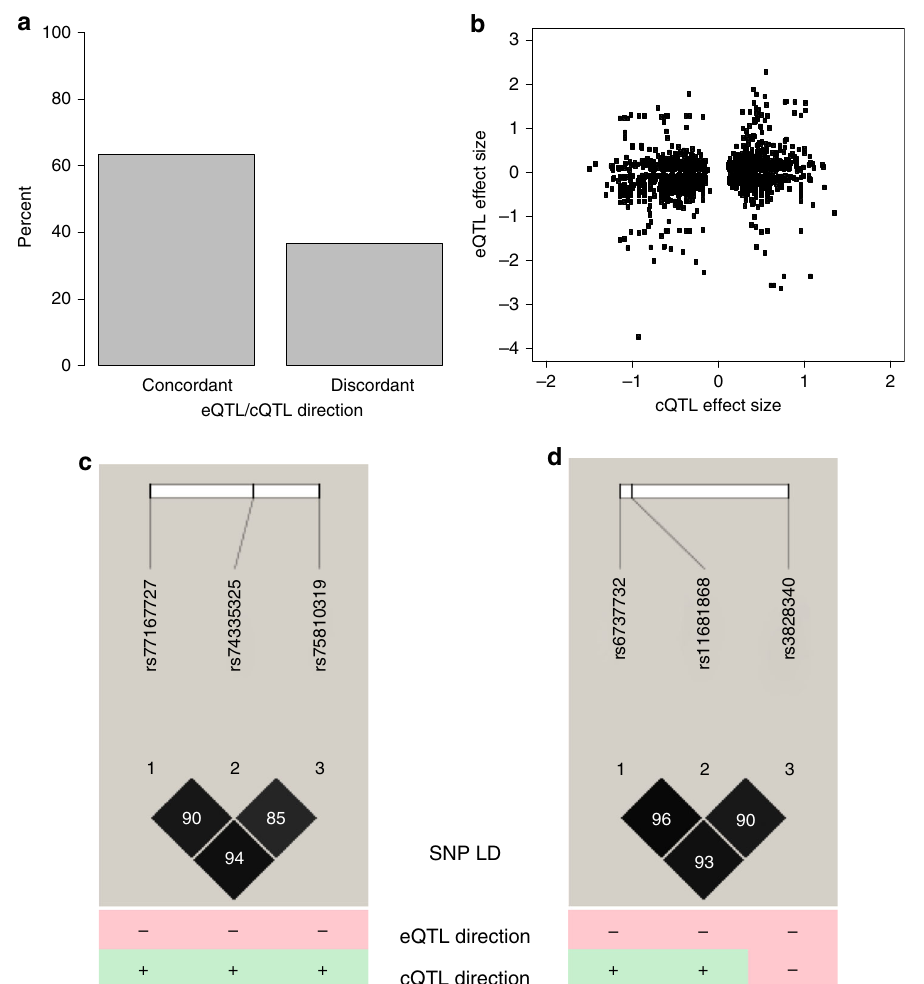
Fig. 6 SNPs that are both eQTLs and cQTLs. a Direction of effects of cQTL vs. eQTL. Concordant effects are when cQTL allele associated with greater open chromatin is also associated with higher eQTL expression. b Even though the direction of cQTL and eQTL is largely concordant, the effect sizes of these differences are only modestly correlated ( r = 0.21). c Three SNPs in high LD on chromosome 1. The tested allele is associated with lower expression and more open chromatin for all three SNPs. Distance between SNPs 1 and 2 is 10 kb, and distance between SNPs 2 and 3 is 6.3 kb. d Three SNPs in high LD on chromosome 2. The tested allele is associated with lower expression in all three instances, but with more open chromatin for two SNPs and more closed chromatin for the third SNP. Distance between SNPs 1 and 2 is 2 kb and distance between SNPs 2 and 3 is 20